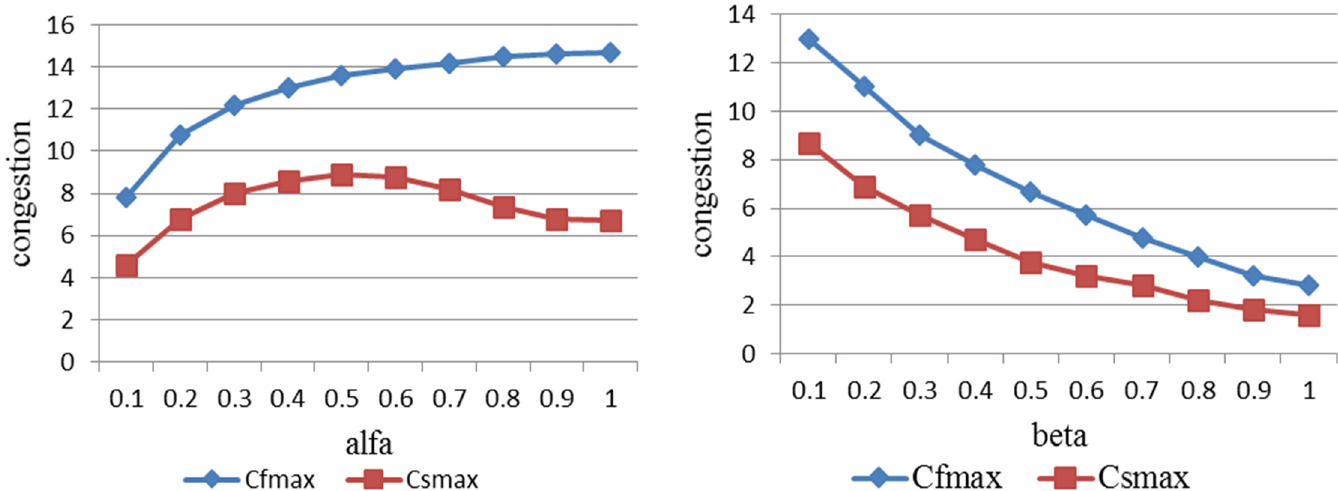
Fig 7. Congestion peaks with main parameters. (A) Congestion peaks with α values (0.1 – 1). (B) Congestion peaks with β values (0.1 –